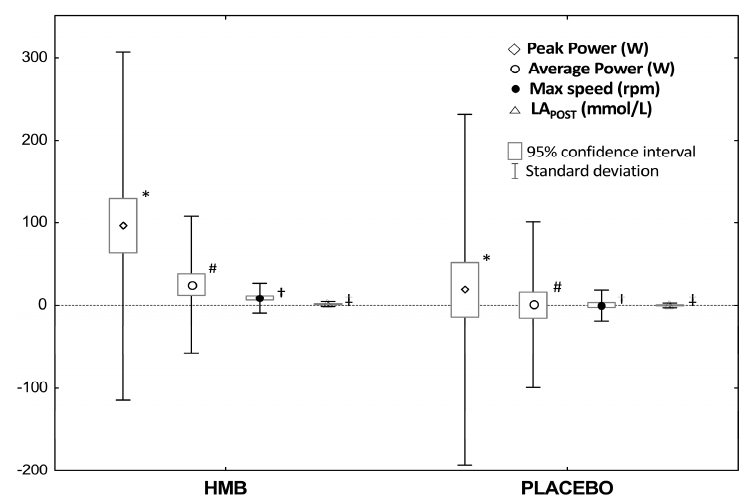
Figure 4. Changes in the anaerobic capacity after 12-week supplementation of HMB and placebo. Values are means ± SD and 95% CI. Abbreviations: HMB, β -hydroxy- β -methylbutyric acid; LA POST , post-exercise lactate concentrations. Significant differences compared with placebo: * p = 0.005 (dependent samples t -tests); # p = 0.029 (dependent samples t -tests); † p < 0.001 (dependent samples t -tests). ‡ p < 0.0001 (dependent samples t -tests). Table 5. Levels of the monitored anaerobic capacity parameters before and after the 12-week supplementation with HMB and placebo